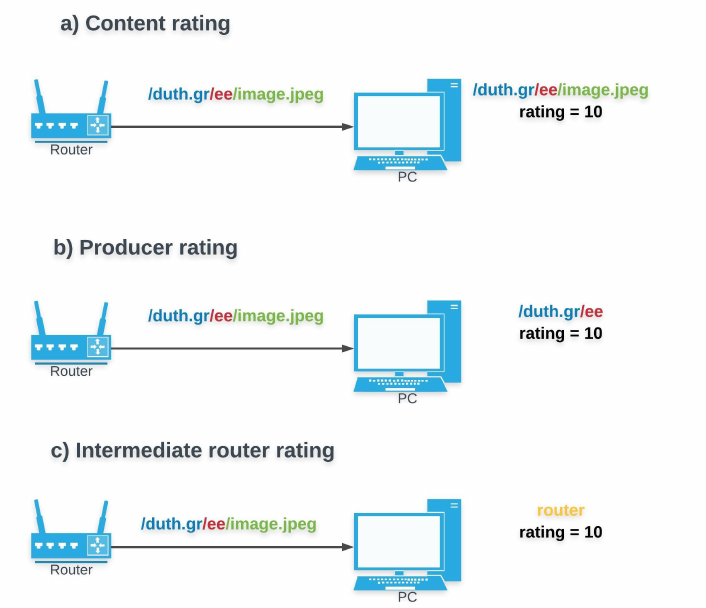
Figure 1. ( a ) Content Rating vs ( b ) & ( c ) Network Entity